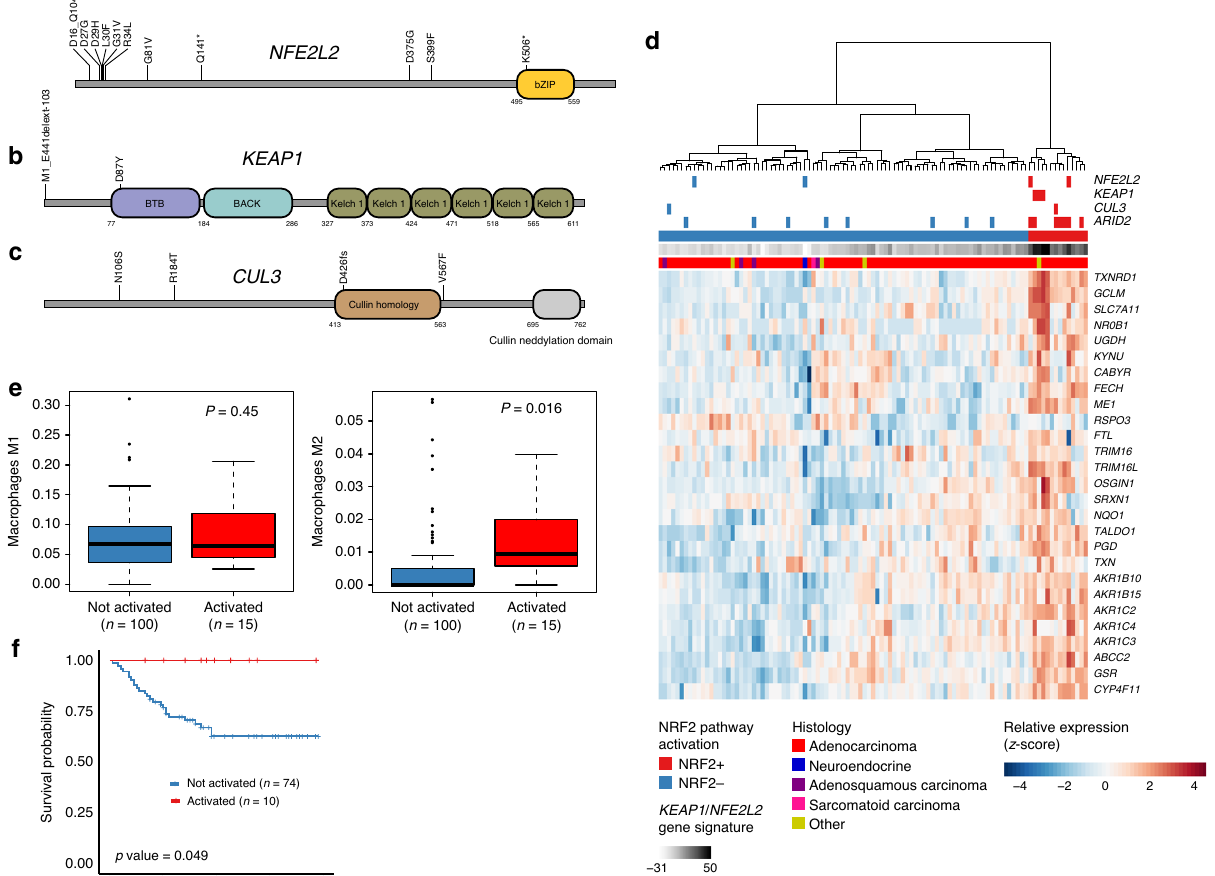
Fig. 5 KEAP1/NFE2L2 pathway activation in GBC. Schematics of alterations in NFE2L2 ( a ), KEAP1 ( b ), CUL3 ( c ) from exome, and RNA-seq splicing events ( n = 166). d Hierarchical clustering of GBC samples based on 27 NFE2L2 downstream target genes. Color bars at top of heatmap indicate alterations in NFE2L2, KEAP1, CUL3, ARID2, pathway activation status, and pathway activation score for samples with RNA-seq and paried exome data ( n = 101). e RNA- seq estimated levels for M2 and M1 macrophages for NRF2-/NRF2 + samples (two-tailed Mann – Whitney test). f Kaplan – Meier survival plot of NRF2-/ NRF2 + samples. Log-rank test p values are represented for each